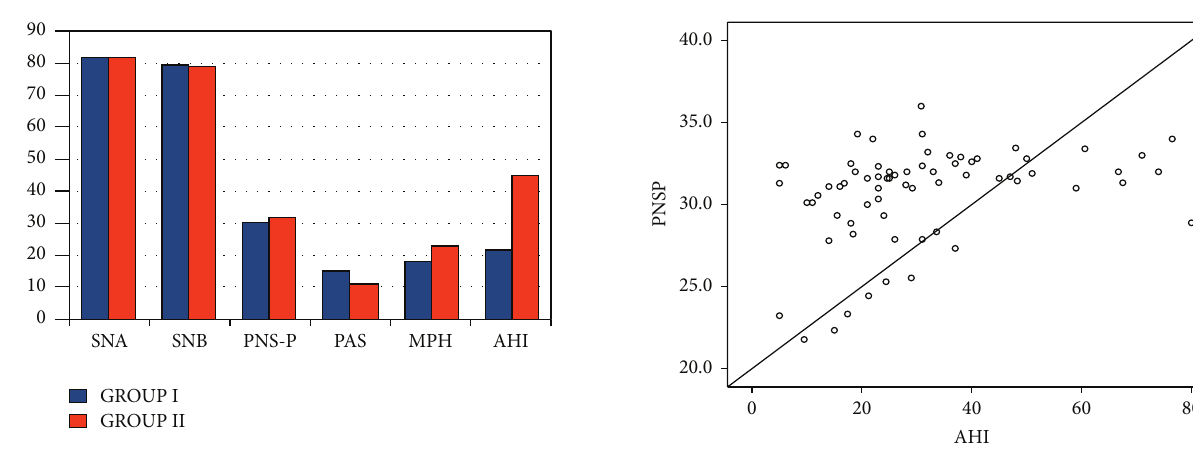
Figure 5: Positive correlation of AHI with PNS-P.